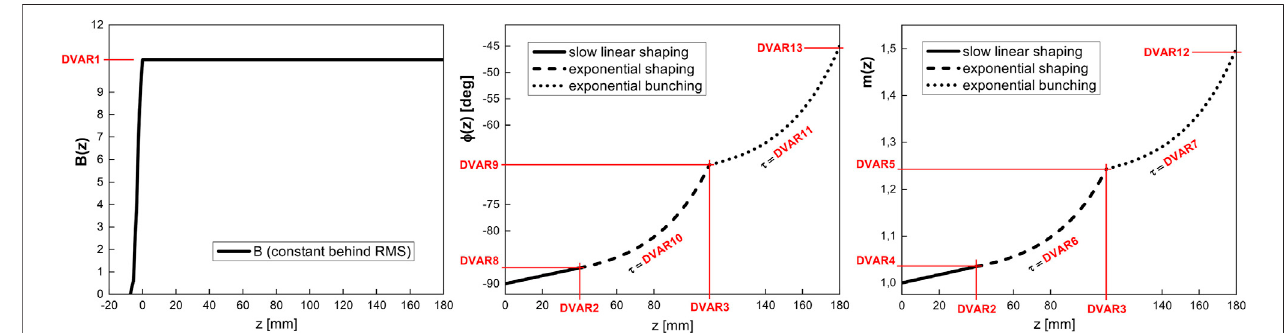
FIGURE 2 | Parametrization functions for the RFQ cell properties speci fi ed by design variables (DVARs): The transversal focusing parameter B ( z ) is kept constant behind the Radial Matching Section (RMS), with DVAR1 determining the absolute value. Regarding the synchronous phase ϕ ( z ) and the electrode modulation m ( z ), the RFQ issubdivided intothree sections(slow linearshaping,exponentialshaping and exponential bunching),thelengthsofwhich arede fi ned byDVARs2and3.The total slope and the smoothness of the occurrence of the shaping/bunching effect are characterized by DVARs 4 – 13. Qualitatively, this overall design approach corresponds to a previously developed beam dynamics design using the PARMTEQM RFQ design tools and additionally applying manual changes to the design functions.